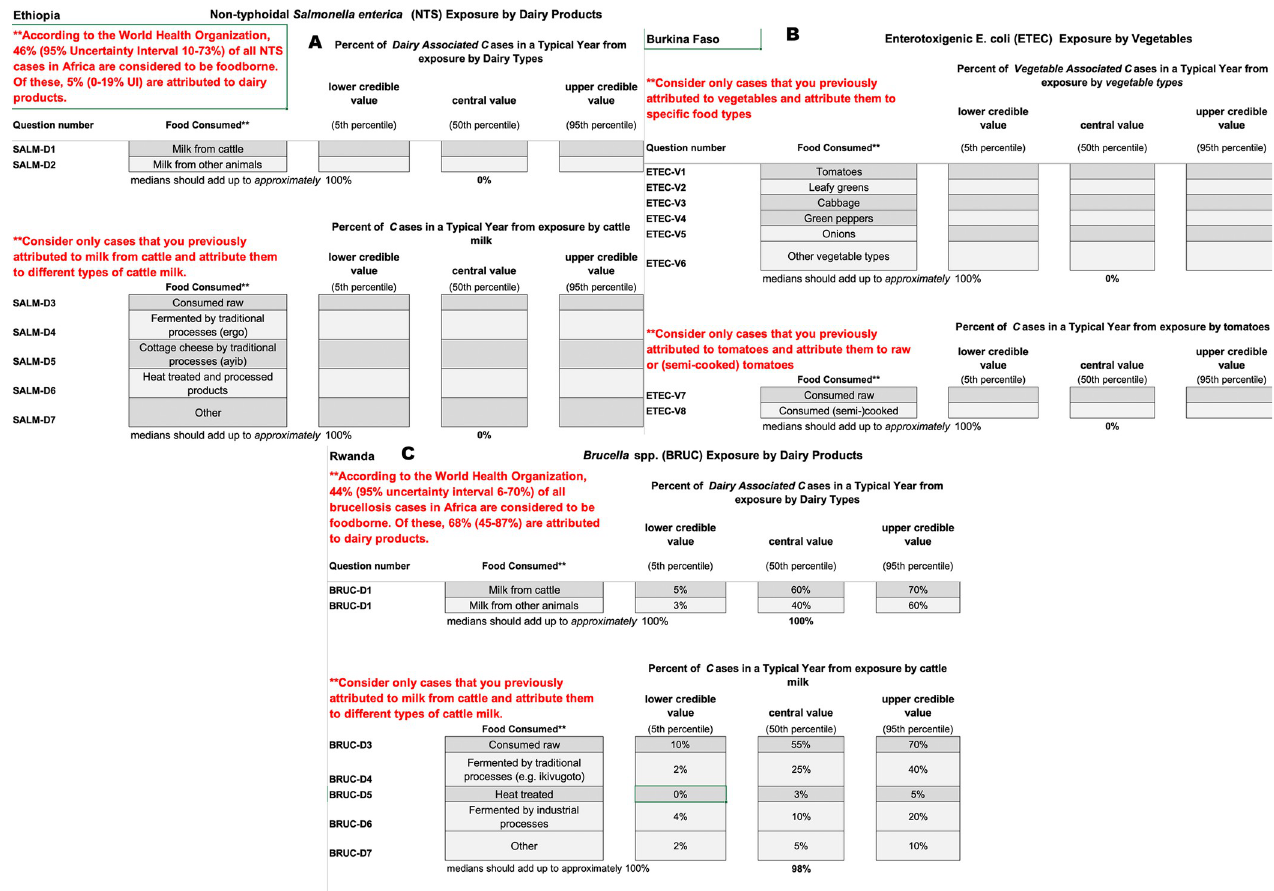
Fig 3. Example target question used in Ethiopia to attribute the burden of foodborne disease to food groups (ETEC only), food types or food products.